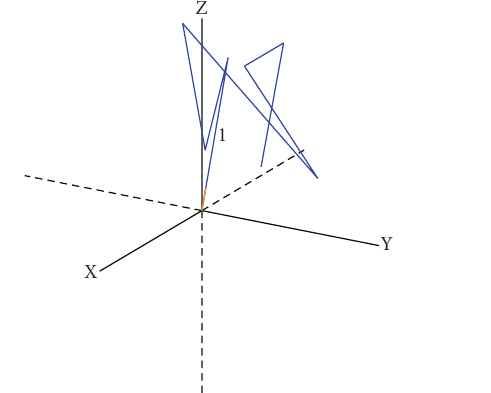
Figure 2: Linden’s GA optimized crooked-wire antenna with C = 234.